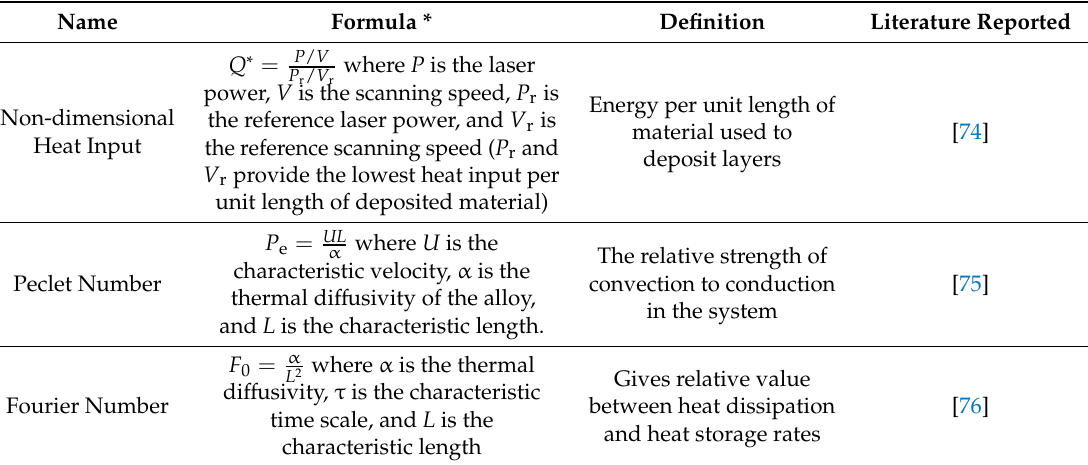
Table 3. Dimensionless numbers and their